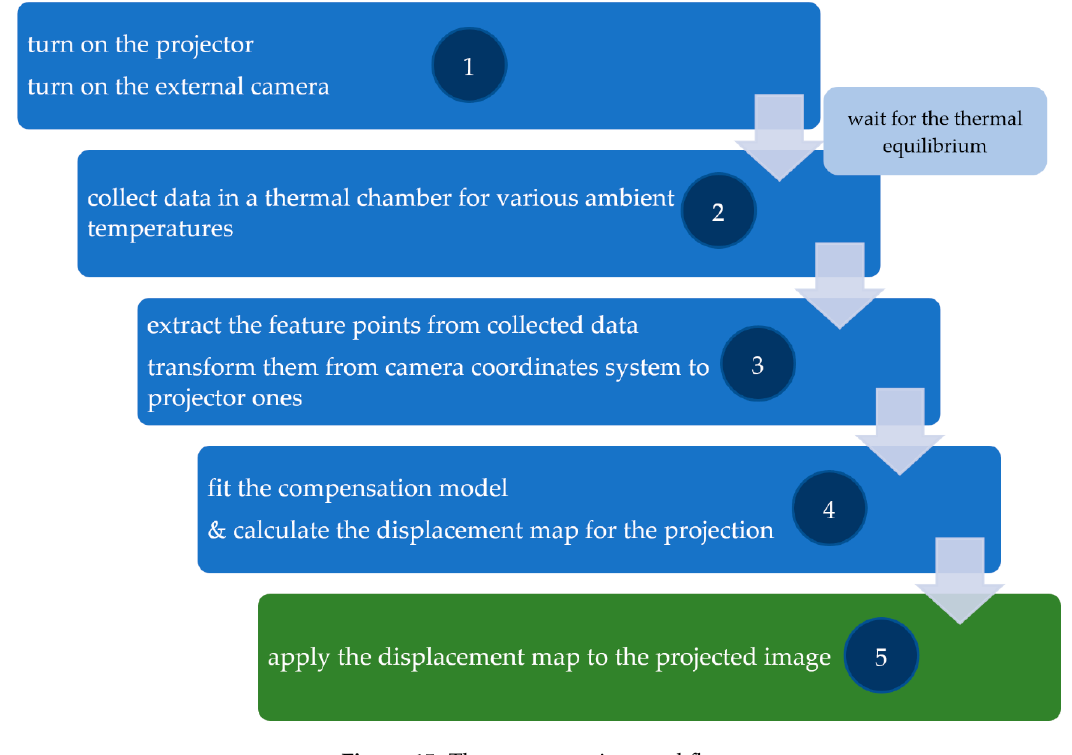
Figure 15. The compensation workflow.